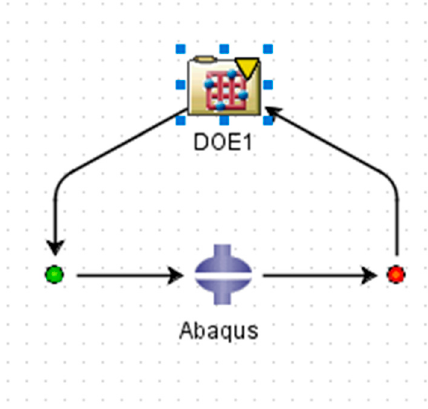
Figure 13. DOE loop.